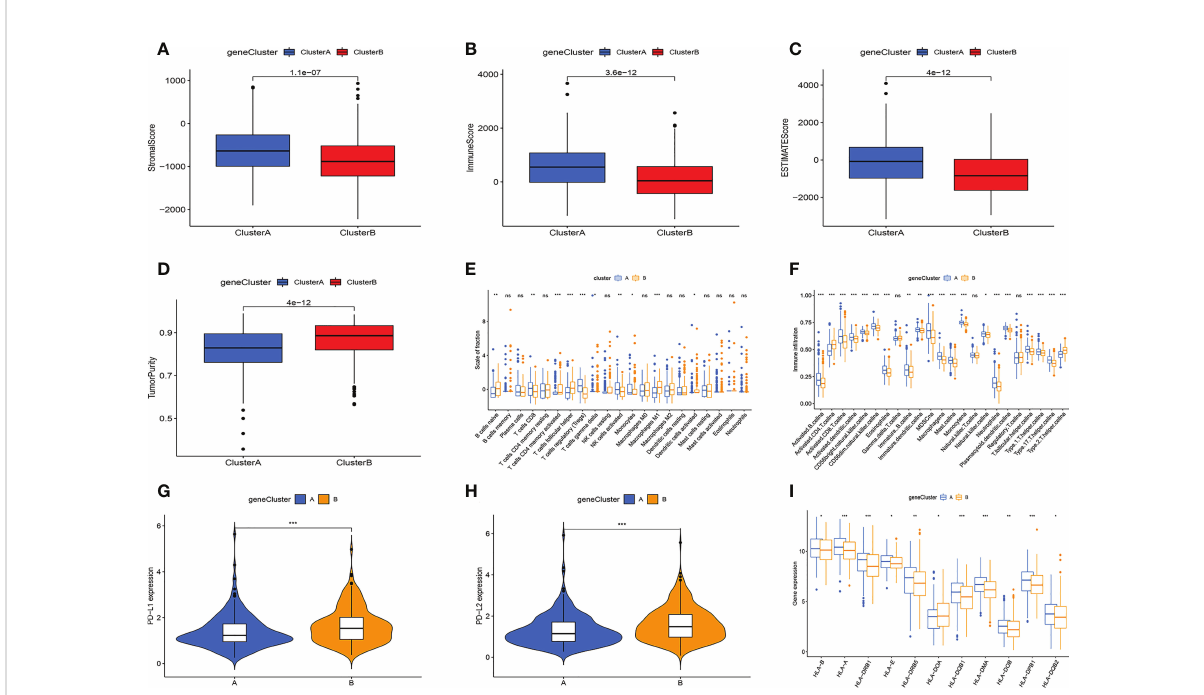
FIGURE 3 Multi-omics analysis based on differential genes cluster. (A-D) TME analysis. Subtype A has higher TME scores and subtype B has higher tumor purity. (E, F) The amount of immune cell in fi ltration differed signi fi cantly. (G) PD-L1, PD-L2 expression levels are higher in subtype (B-H) The A subtype has higher expression levels of HLA-related genes. Adjusted p-values were shown as ns, not signi fi cant; *p < 0.05; **p < 0.01; ***p <